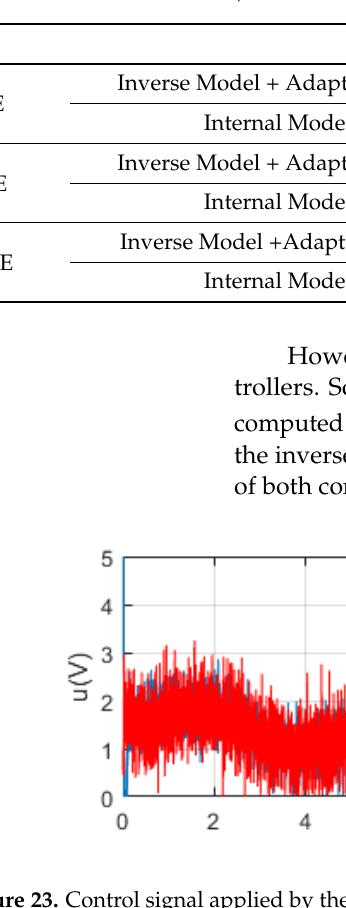
Table 11. ISE, IAE and ITAE values for the inverse model and the internal model controller.